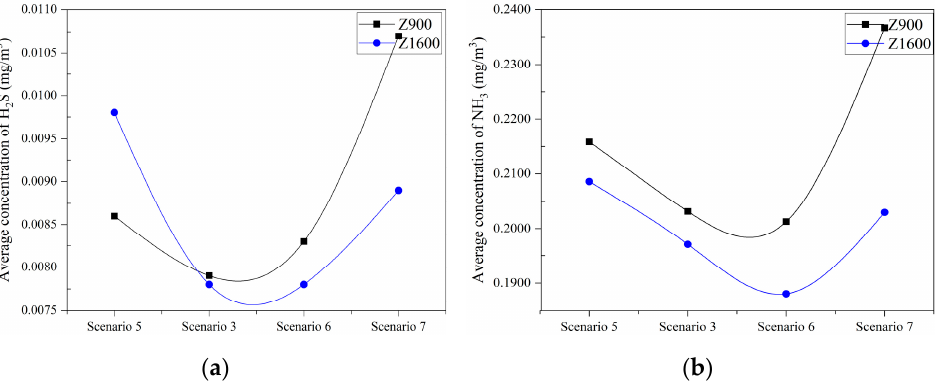
Figure 8. Variation trend in the ACIPs with different exhaust vent air velocities. ( a )Average concentration of H 2 S; ( b )Average concentration of NH 3 .